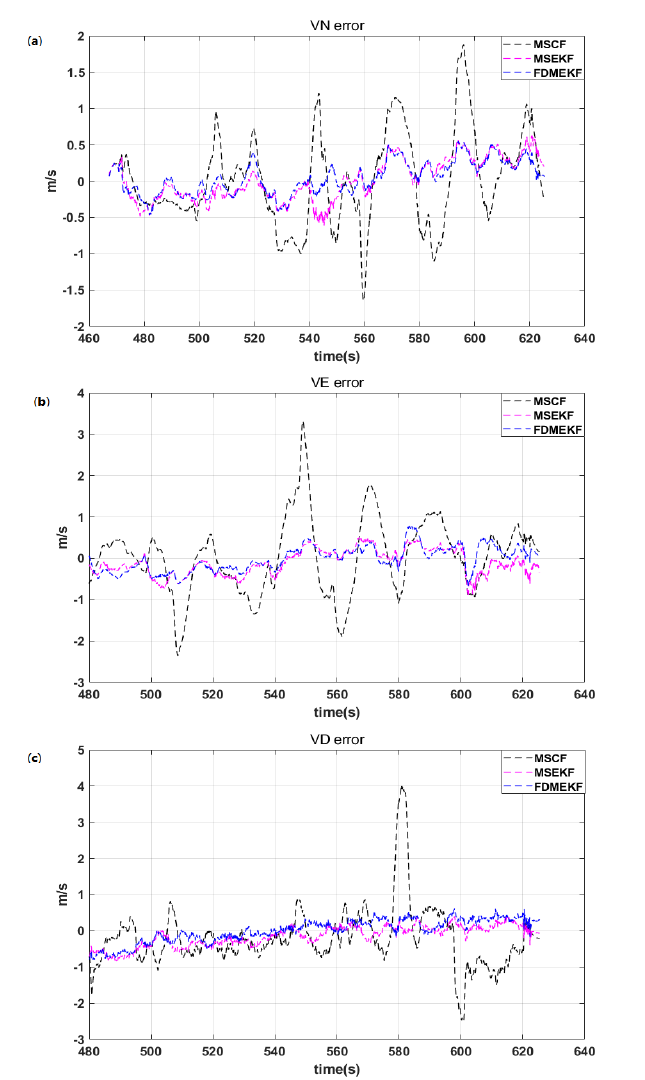
Figure 10. The velocity error the UAV in flight. ( a ) the north velocity error of the UAV; ( b ) the east velocity error of the UAV; ( c ) the down velocity error of the UAV. Table 2. MAE, STD, and RMSE of the velocity achieved by MSCF, MSEKF, and FDMEKF for the experimental